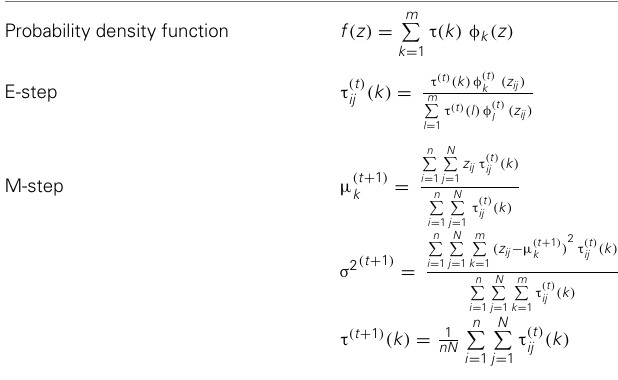
Table 1 | EM algorithm adopted for this study. Probability density